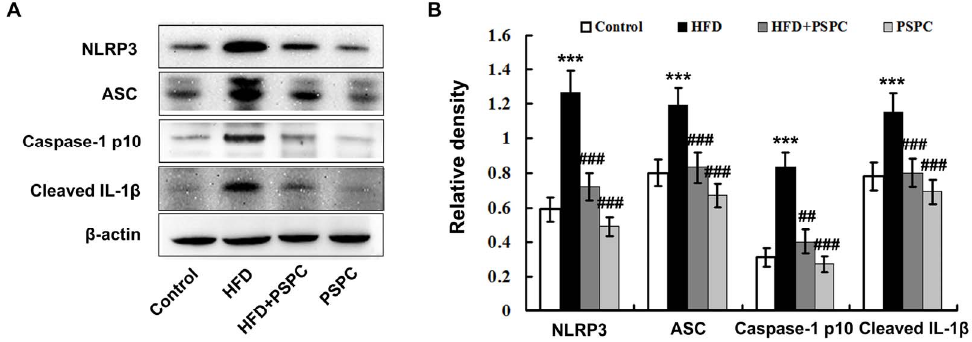
Figure 6. PSPC prevents NLRP3 inflammasome activation in HFD-treated mouse livers ( n = 3). ( A ) Immunoblotting of NLRP3 inflammasome components and cleaved IL-1 β in mouse livers; ( B ) Densitometry analysis of NLRP3 inflammasome components and cleaved IL-1 β in mouse livers. All of the values are expressed as the mean ± SD. *** p < 0.001 vs. the control group; ## p < 0.01, ### p < 0.001 vs. the HFD group.